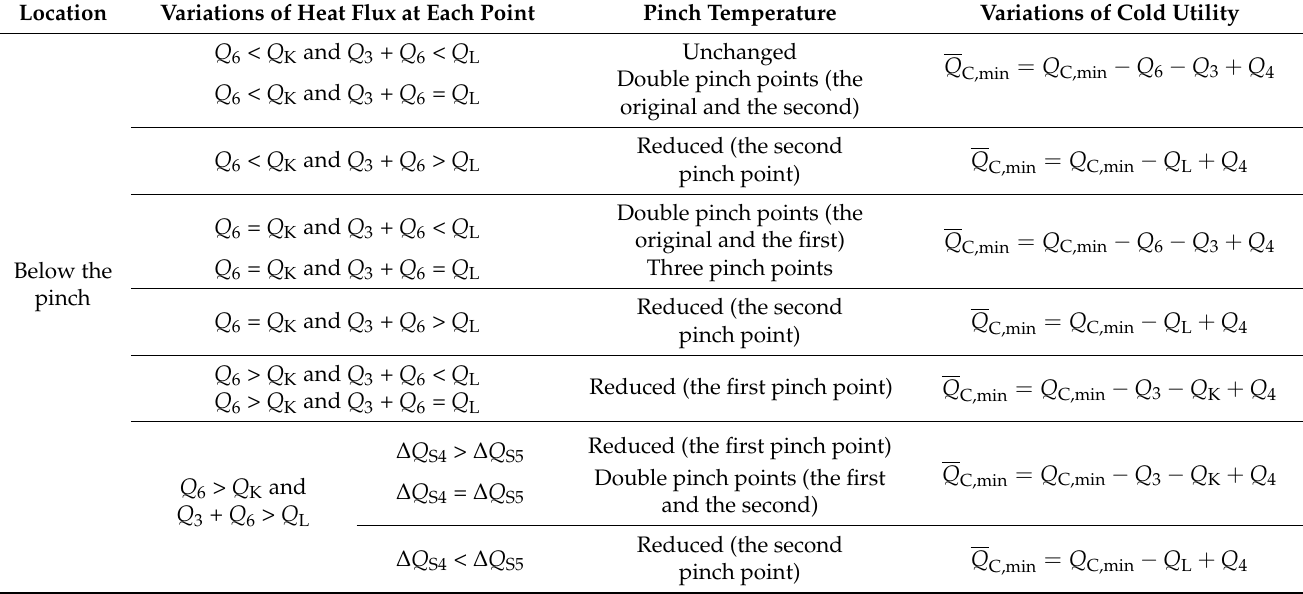
Table 3. Changes of the pinch temperature and cold utility for Case